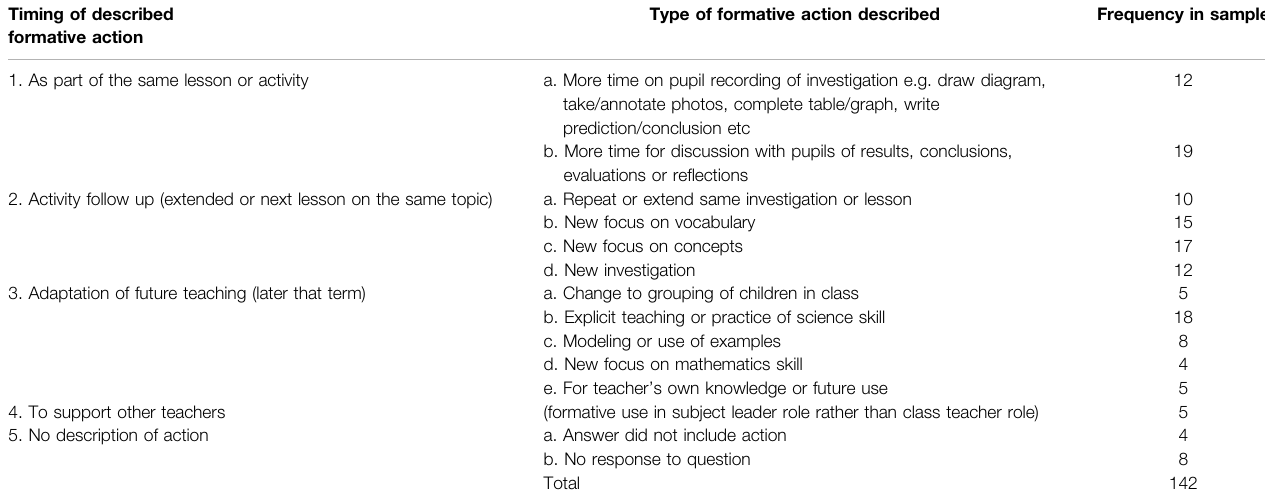
TABLE 2 | Frequency of formative actions described by